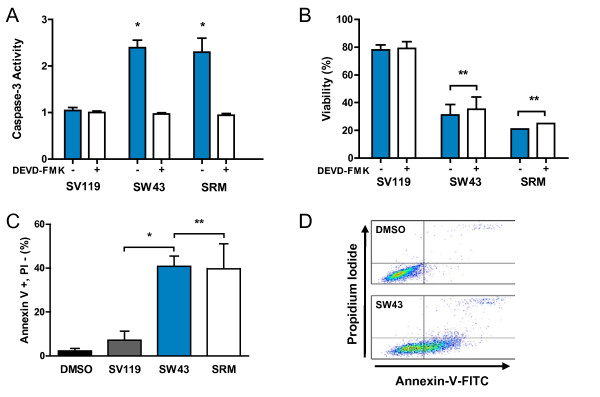
Sigma-2 ligands induce caspase-3 activation in pancreas cancer. Panc02 cells were pre-treated with caspase-3 inhibitor (DEVD-FMK 1 μM) or DMSO vehicle for one hour prior to exposure to sigma-2 ligands (25 μM) SV119, SW43, siramesine (SRM) or DMSO vehicle for 18 hours. A. Caspase-3 activation was quantified by cleavage of the fluorogenic substrate Ac-DEVD-AMC and expressed relative to vehicle. The caspase-3 specific inhibitor DEVD-FMK abrogates caspase-3 dependent cleavage. B. Caspase-3 inhibition does not protect cells from sigma-2 ligand induced cell death. C. Flow cytometry for Annexin-V verifies apoptosis by sigma-2 ligand. D. Representative flow cytometry dot plot showing cells moving from Annexin-V negative quadrant (upper panel) with vehicle towards Annexin-V positive quadrant (lower panel) with SW43 treatment. (Means ± SEM), n ≥ 3, *p < 0.05, **p > 0.05.